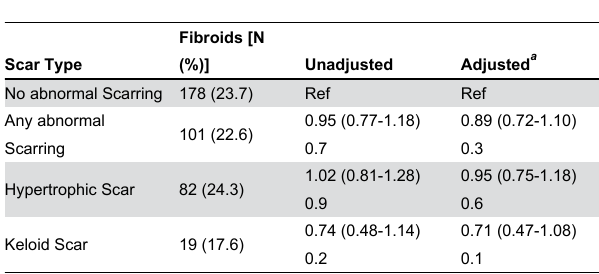
Table 1. Baseline Characteristics of Participants by Self- Reported Scar.